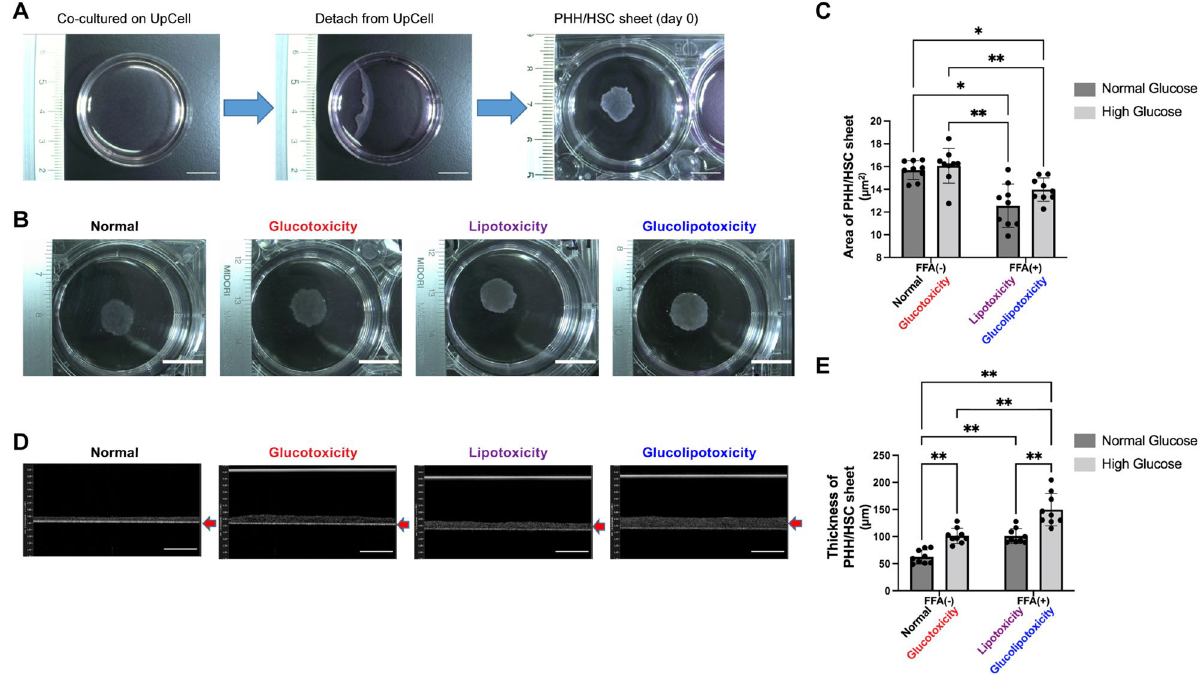
Figure 2. PHH/HSC sheet analysis. ( A ) PHH/HSC sheet fabrication. PHHs and HSCs were co-cultured on 35 mm or 24-well UpCell culture plates at 37 °C for 4 days. After, the UpCell plates were incubated at 20 °C for 30 min following which the PHH/HSC sheets were detached from the surface, contracted, and became 3D. Scale bar, 10 mm. ( B ) PHH/HSC sheet on day 11 fabricated on 35 mm UpCell dishes, viewed from the top. Scale bar, 10 mm. ( C ) Area of the PHH/HSC sheet fabricated on 24-well UpCell dishes. The area of sheets in the lipotoxicity and glucolipotoxicity groups was smaller than that in control and glucotoxicity groups, n = 9, 3